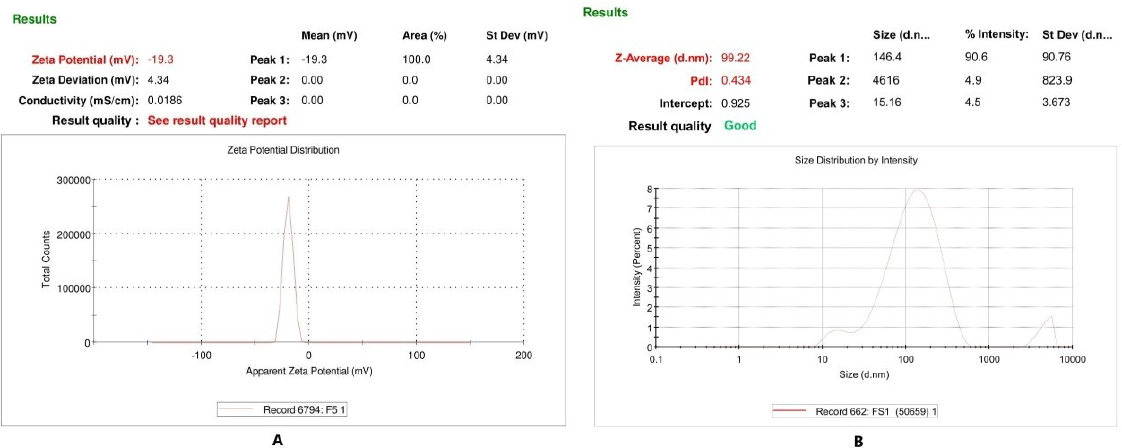
Figure 3. Zeta potential ( A ), zeta size, and PDI ( B ) of optimized microemulsion F3.